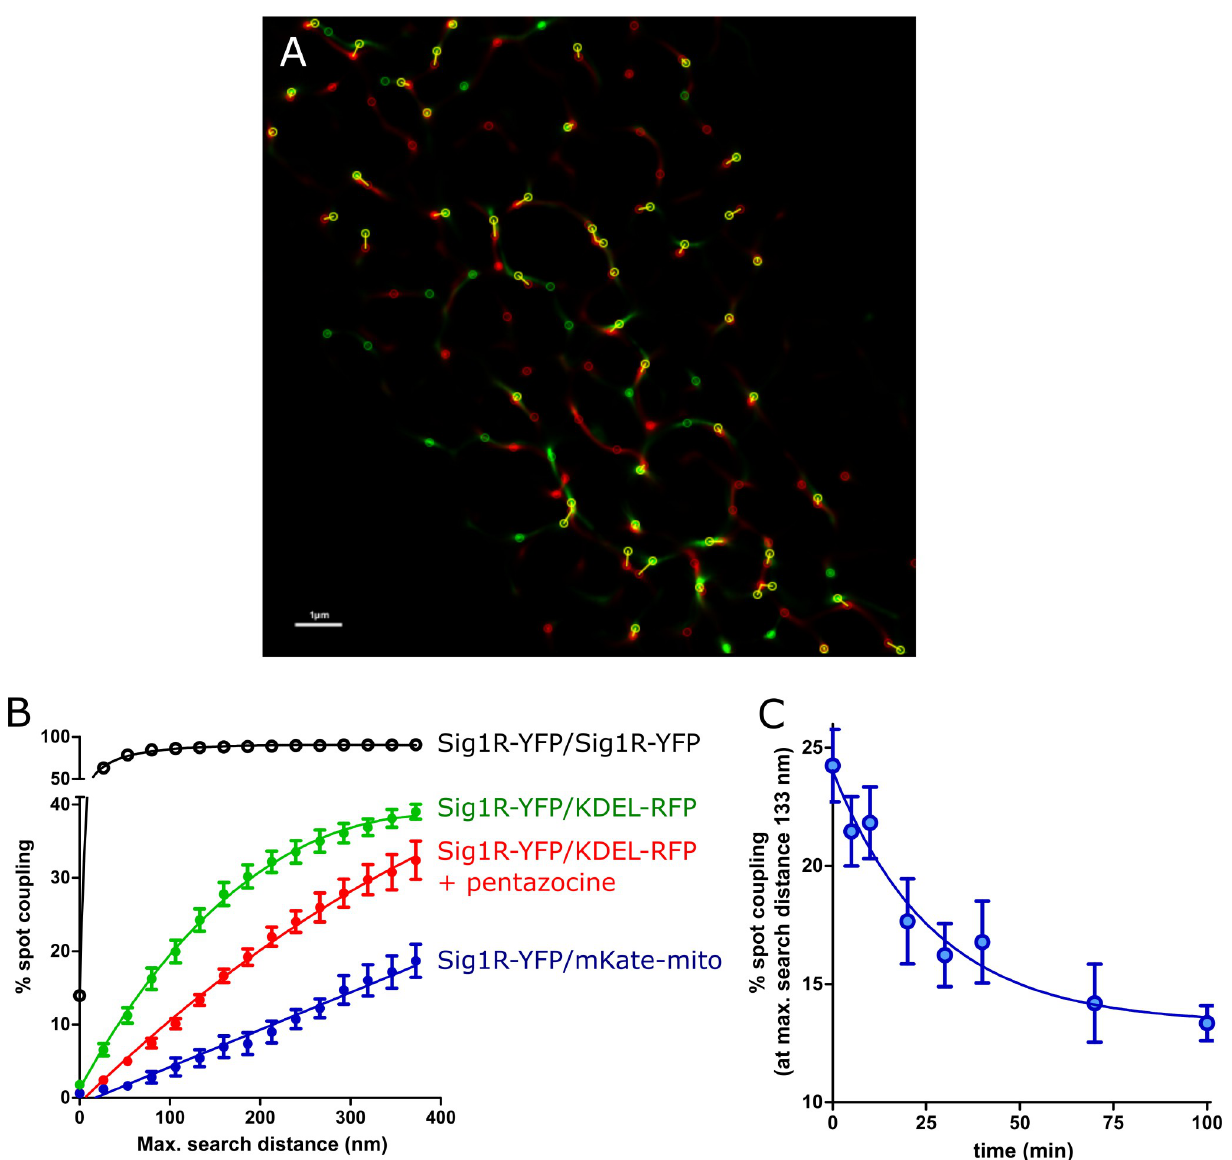
Fig 4. The spot coupling analysis. (A) Zoomed SRRF image of Fig 3F indicating spot coupling of Sig1R-YFP and KDEL-mRFP, which were extracted using a wavelet spot detector and marked with circles (scale bar 1 μ m). (B) Dependence of the level of spot coupling of Sig1R-YFP with KDEL-mRFP (green circles), KDEL-mRFP in the presence of 100 nM (+)-pentazocine (red circles), pmKate2-mito (blue filled circles), and Sig1R-YFP (positive control, black circles) on the search distance from the receptor. The spot coupling analysis was performed with SODA workflow [26], and were presented as the ratio of red channel spots that colocalize with green channel spots to the total number of detected red spots. (C) Change in the spot coupling of Sig1R-YFP with KDEL-mRFP over time after activation of the receptor with 100 nM (+)-pentazocine. The first data point on the x-axis (0 min) indicates the baseline measurement. Spot coupling was calculated at a search distance of 133 nm, which corresponded to 5 SRRF pixels. The data were taken from images with at least 8 or more cells from at least two independent experiments.